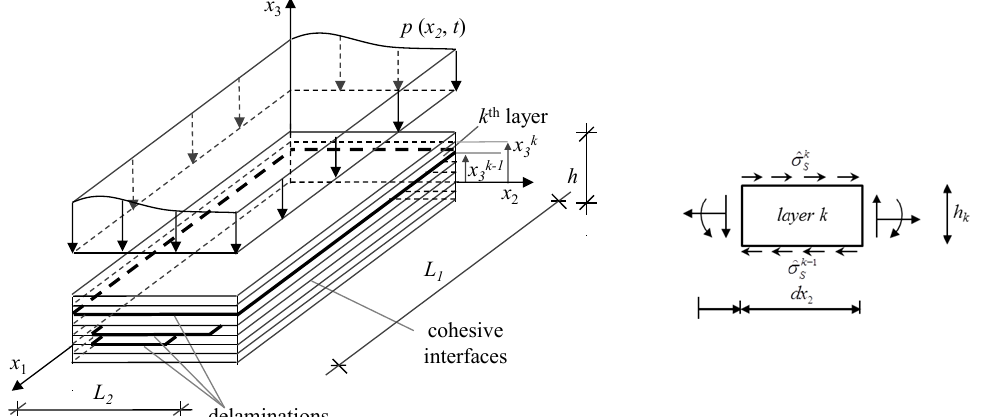
Figure 1: (a) Composite plate showing discretization into layers, imperfect/cohesive interfaces and delaminations. (b) infinitesimal element of layer k showing stress resultants and couples and interfacial